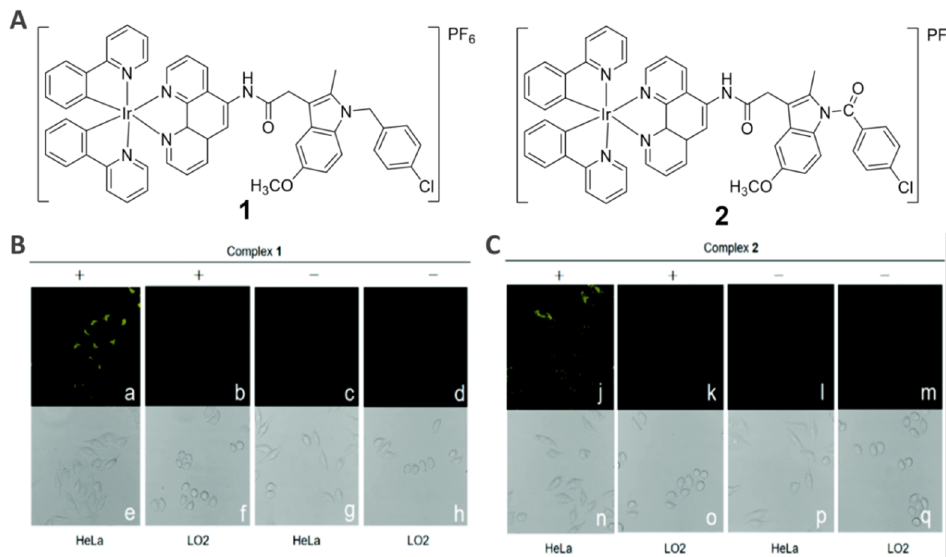
Figure 3. ( A ) Chemical structures of complexes 1−2 . Living cells stained by ( B ) complex 1 and ( C ) complex 2 (1.0 µ M). (a, c, e, g, j, l, n, p) HeLa cells and (b, d, f, h, k, m, o, q) LO2 cells. The upper row is luminescence imaging, and the lower row is bright field imaging. λ exc = 405 nm. Reproduced with permission from ref. [45]. Copyright 2017 Royal Society of Chemistry.